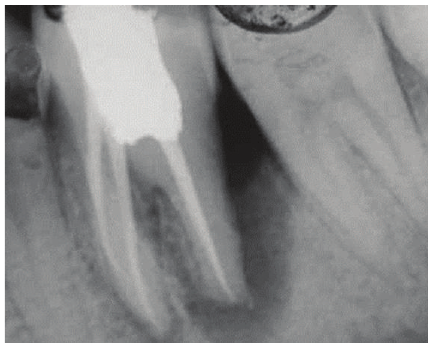
Figure 2: Postobturation.